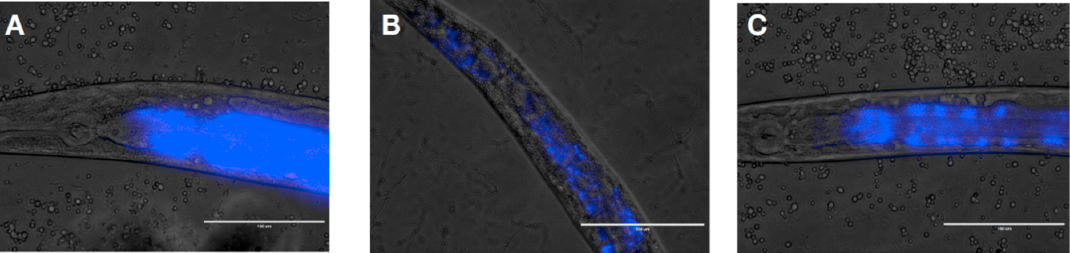
Figure 4. C. albicans colonization of C. elegans gut after 72 h ( A ) and after a 24-h-curative treatment with E. coli OP50 ( B ) or Lcr35 ® ( C ). The blue color represents yeast labeled with DAPI. Scale bar = 10 µ m.